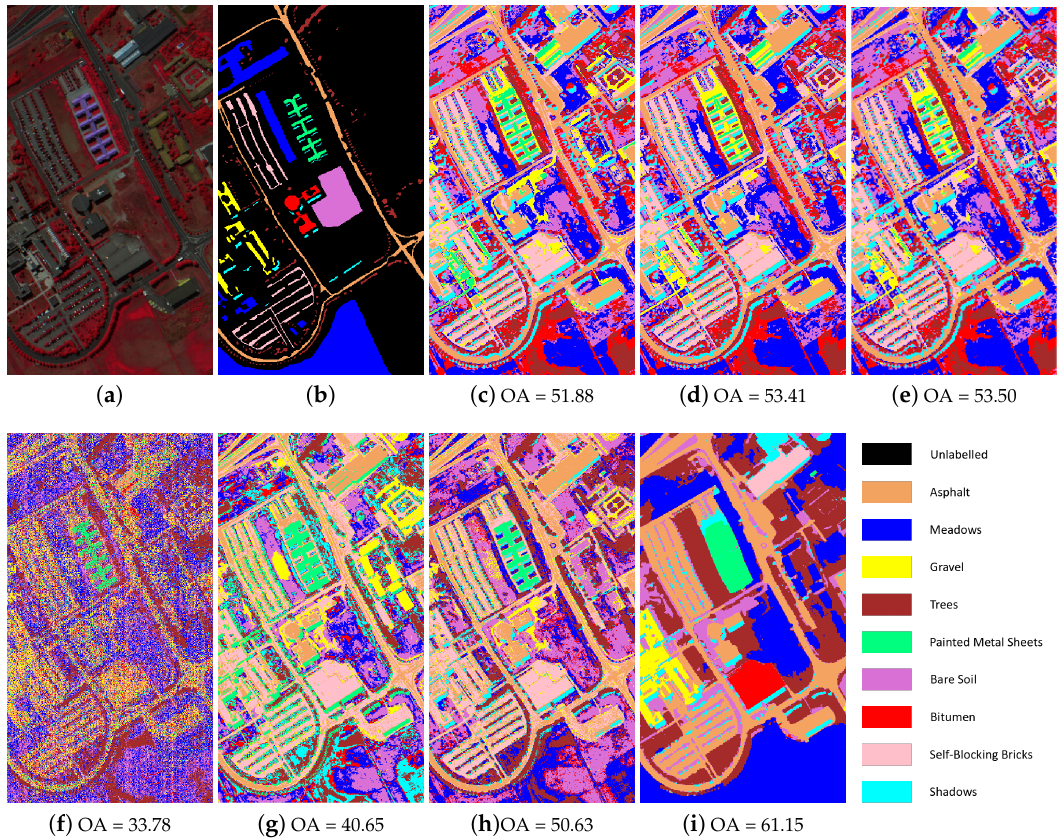
Figure 6. Pavia University image. ( a ) False color image, ( b ) Ground truth, and Clustering maps of ( c ) FCM, ( d ) k-means, ( e ) RSC, ( f ) SSSC, ( g ) SSC-OMP, ( h ) Sketch-SSC and ( i )